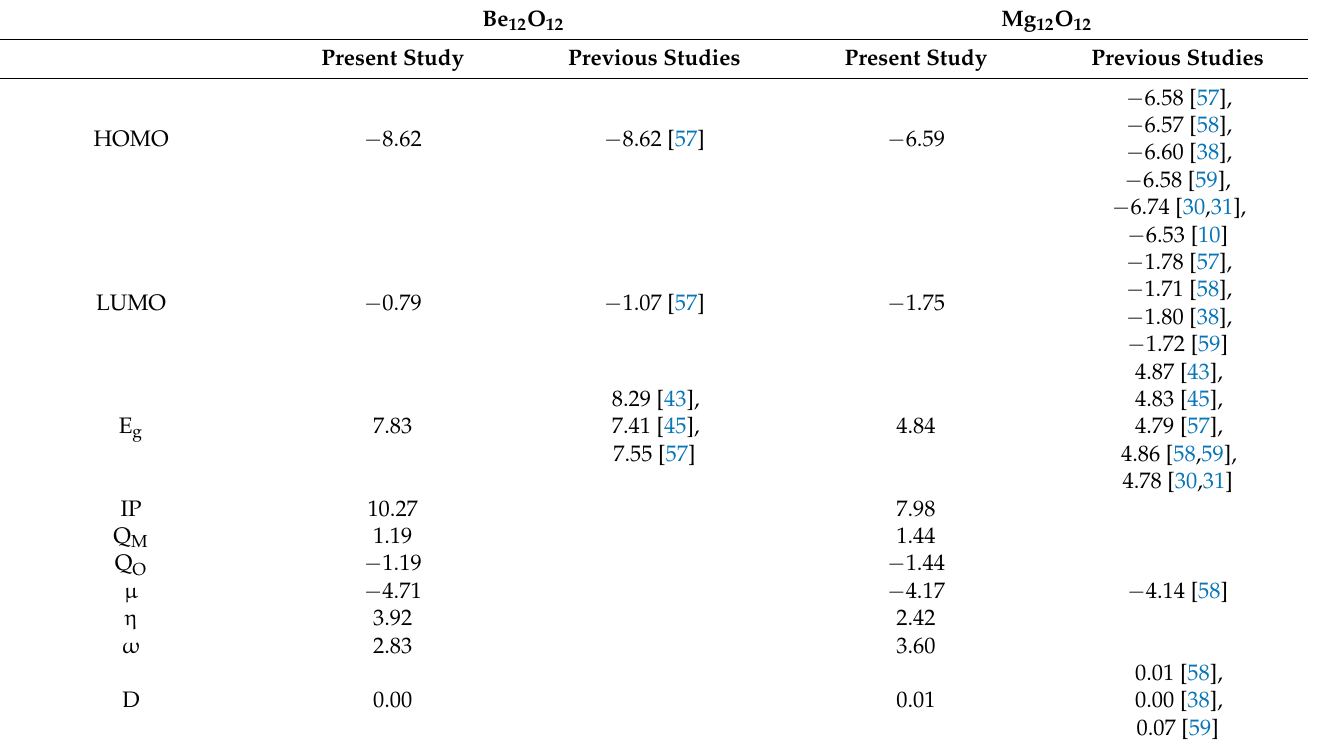
Table 1. Electronic properties of Be 12 O 12 and Mg 12 O 12 nano-cages. HOMO and LUMO energy levels (eV), HOMO- LUMO gap (E g , eV), ionization potential (IP, eV), NBO charges (Q, e), chemical potential ( µ , eV), hardness ( η , eV), electrophilicity ( ω , eV), and dipole moment (D, Debye). Be 12 O 12 Mg 12 O 12 Present Study Previous Studies Present Study Previous Studies